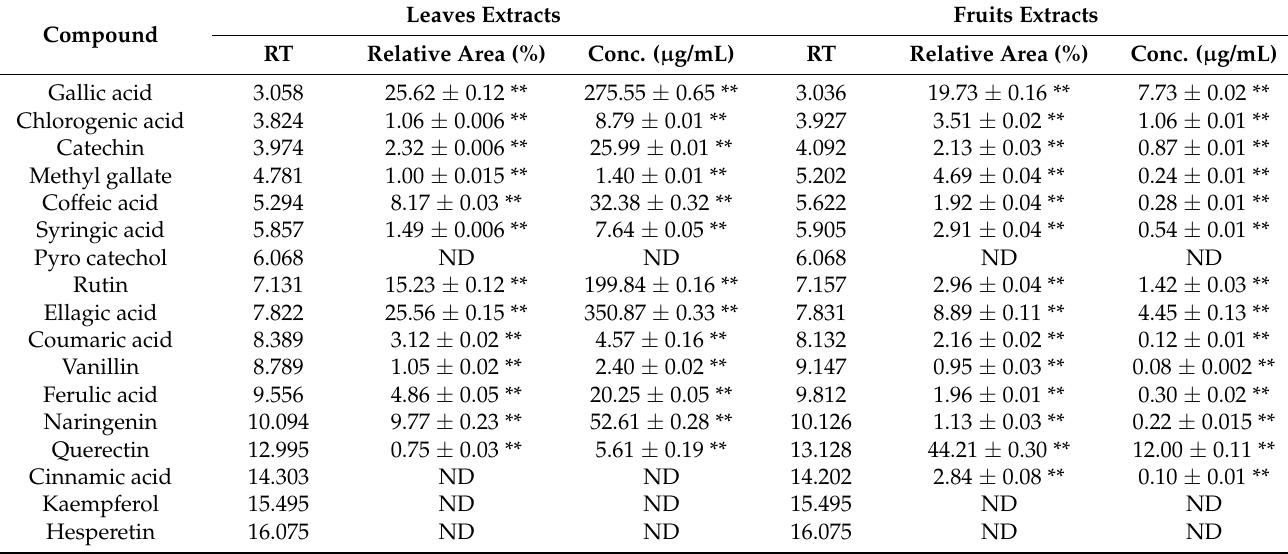
Table 1. Polyphenols compounds determined by HPLC in crude methanolic extracts of Z. spina-christi leaves and